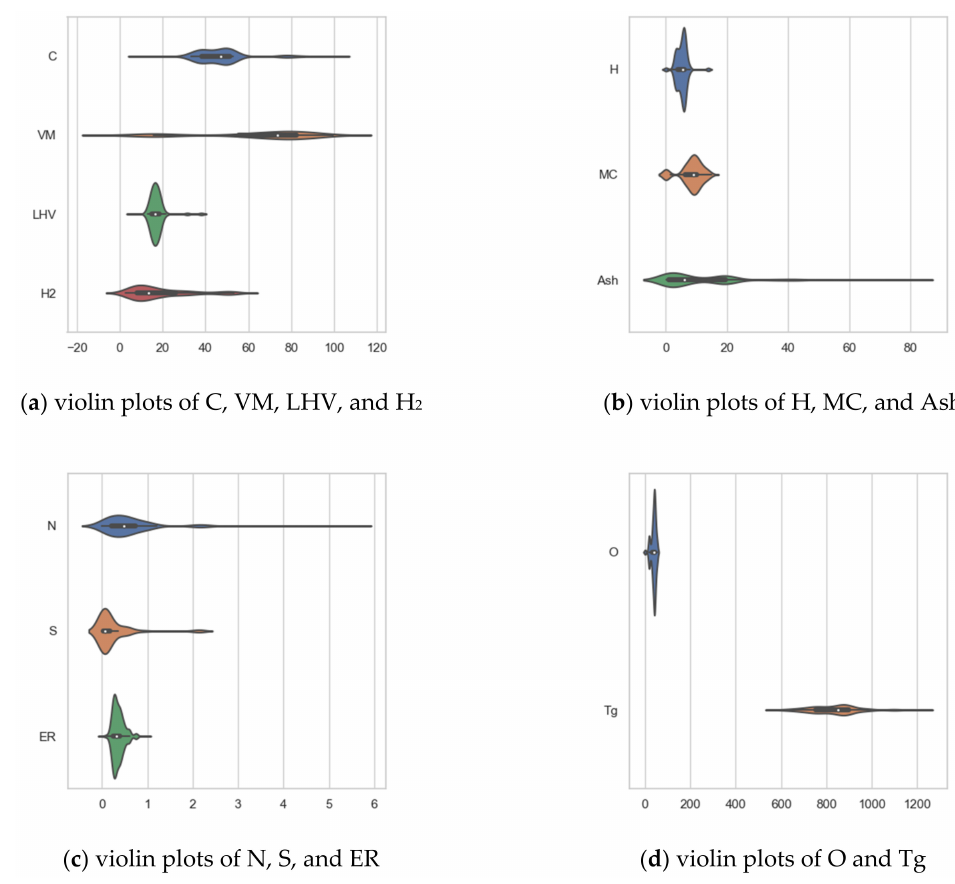
Figure 4. Violin plots of the model input features and target H 2